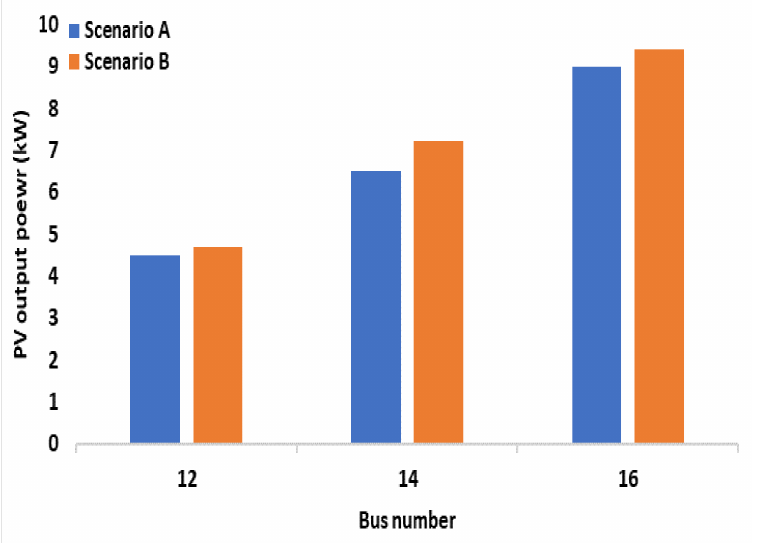
Figure 8. Total active power dispatched by PVs in all scenarios at candidate buses. Table 3. Busbars with highest power dispatch with